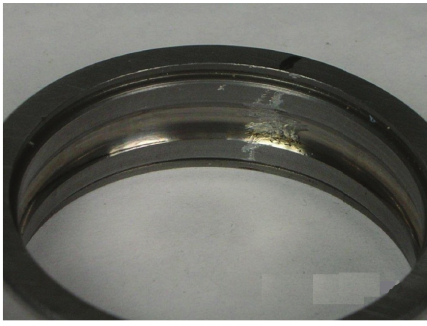
Figure 22: Picture of outer race fault